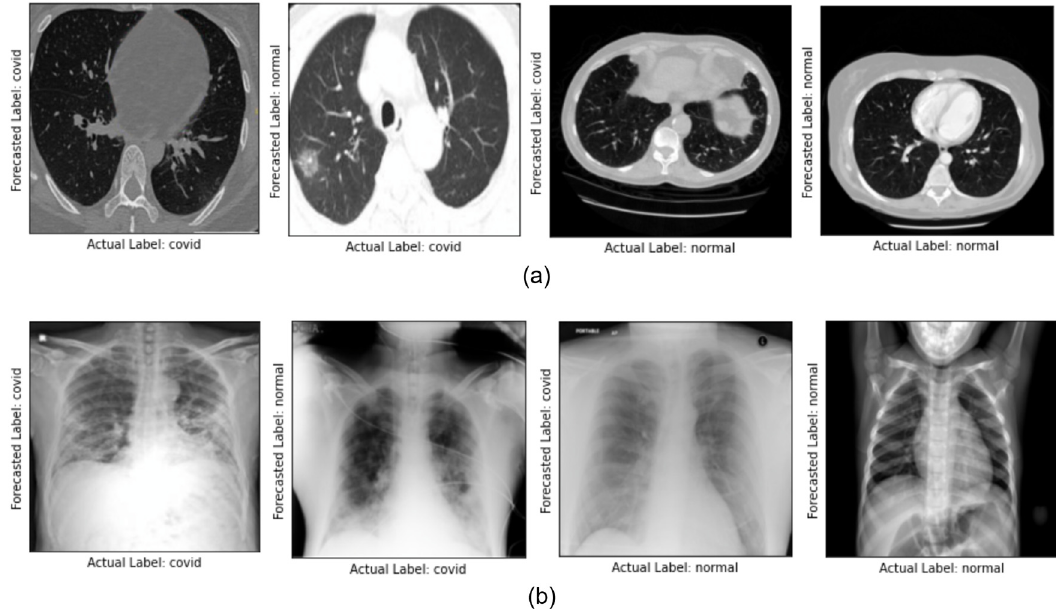
Figure 8. Prediction result of proposed SCovNet model ( a ) CT scan dataset and ( b ) CXR Images dataset.